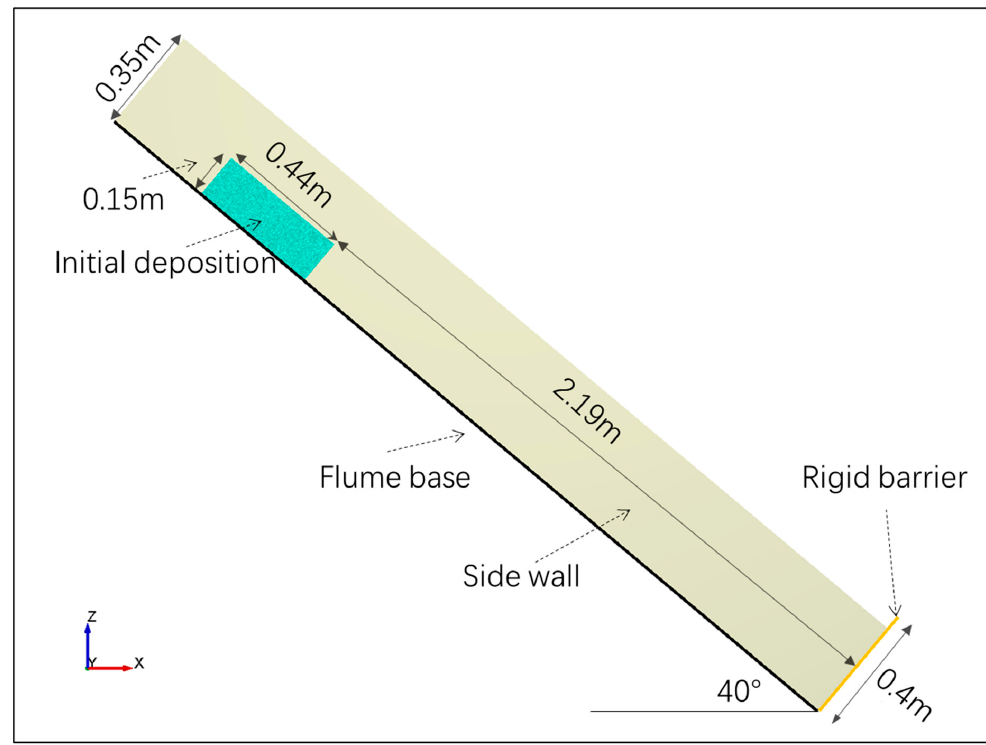
Figure 1. Discrete element method (DEM) model.